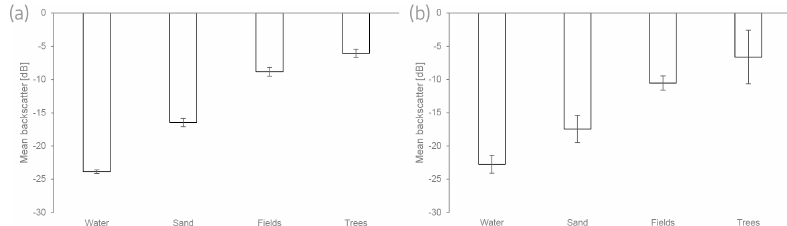
Figure A4. Average backscatter for four land cover classes (a) for a sampling duration of 0.5 months and a 25 × 25 boxcar filter and (b) for a sampling duration of 7 months and no filter. Bars indicate the mean ± 2 standard deviations. If images are available only from 2 weeks, strong spatial filtering (25 × 25 pixels) reduces the standard deviation enough to separate all four classes even at the level of 2 standard deviations around the mean (a) . If, by contrast, images are available from 7 months, water, sand and fields can be separated even if no spatial filter is applied (b) . In this setting, fields and trees can be distinguished only at the level of 1 standard deviation around the mean (not shown in the graph).